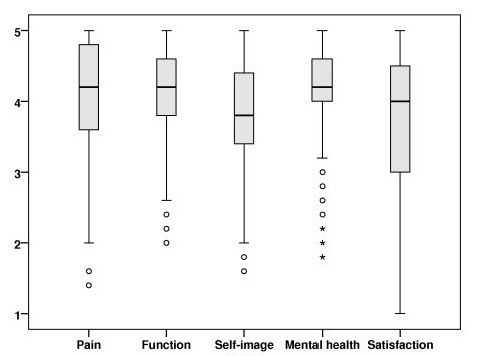
Quality of life at long-term follow-up in late-onset juvenile and adolescent idiopathic scoliosis treated with the Boston brace. Box-plot showing median with 25- and 75 percentiles and outliers for each domain of the SRS-22 (1 = worst possible, 5 = best possible).